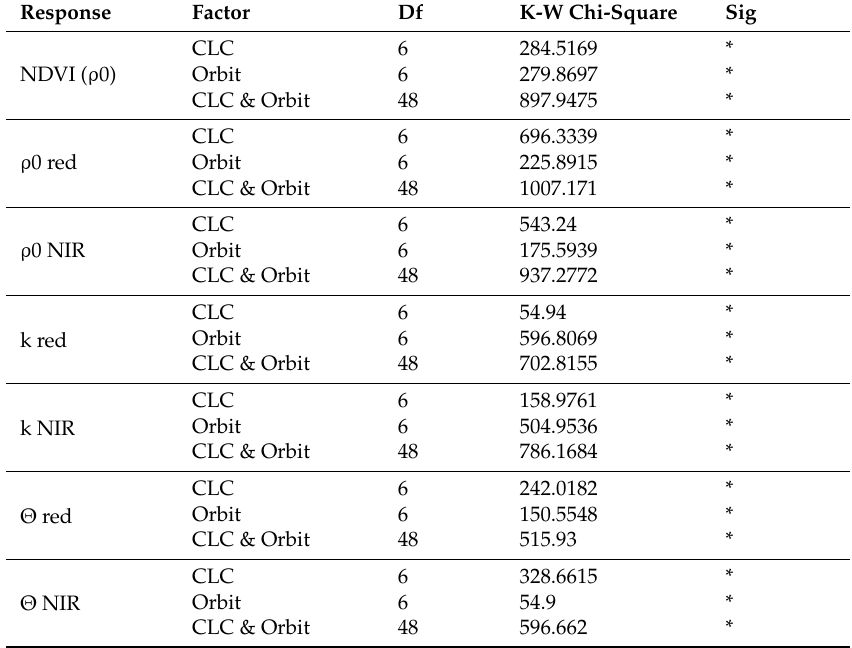
Table 7. Results from the Kruskal–Wallis test (Df is the degrees of freedom, * implying significance at p < 0.01